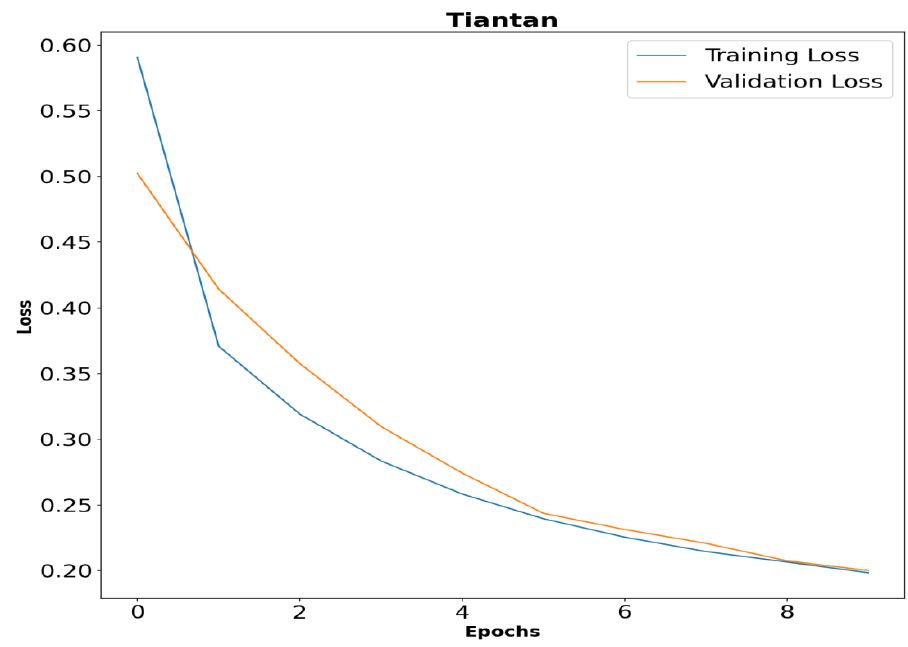
Figure 3. Sample graph of training and validation curve for Tiantan location dataset.